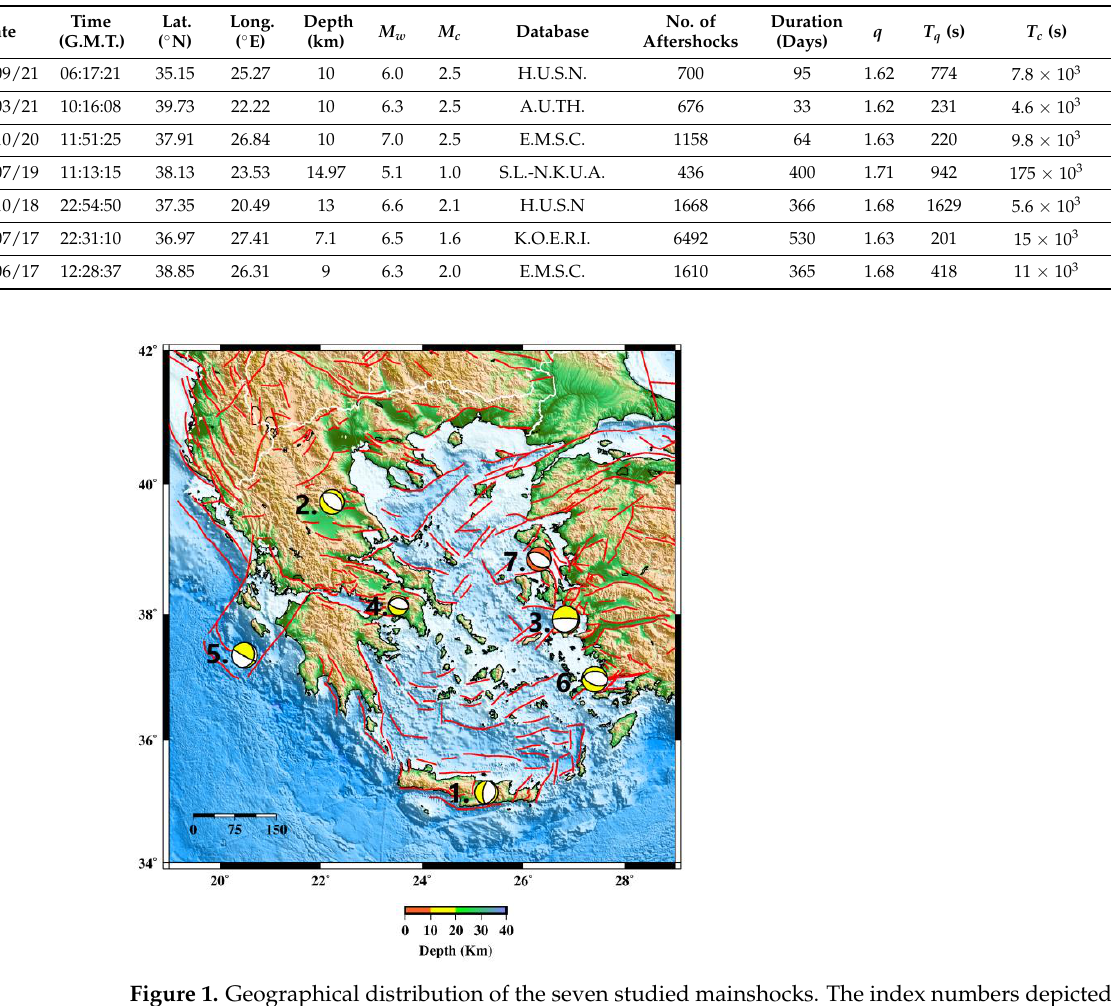
Table 1. Results of all analyzed aftershock sequences, where M c is the completeness magnitude of the catalogue used, q is the Tsallis entropic parameter of the interevent time distribution, T q denotes the generalized scaled interevent time, and T c is the cross-over point at which the transition from Tsallis to BG statistical mechanics occurs.